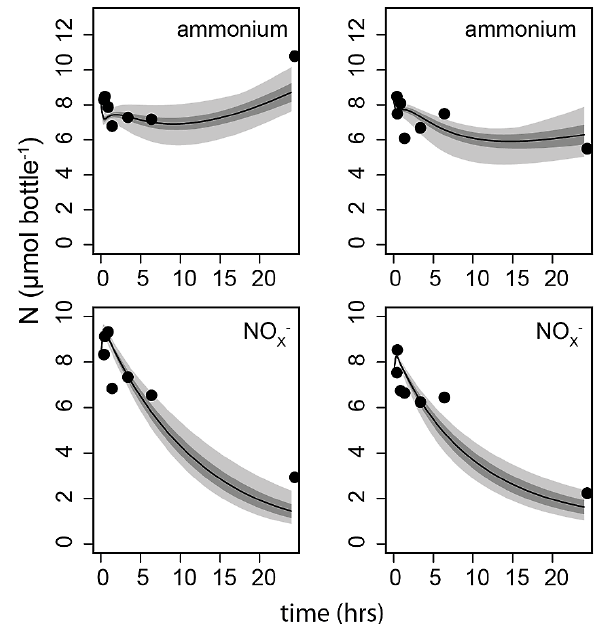
Fig. 3. Data and model fits for concentrations of ammonium and nitrate in dark (left side) and light (right side). The dark shaded area of the modelled curve represents one standard deviation; light shading indicates minimum and maximum